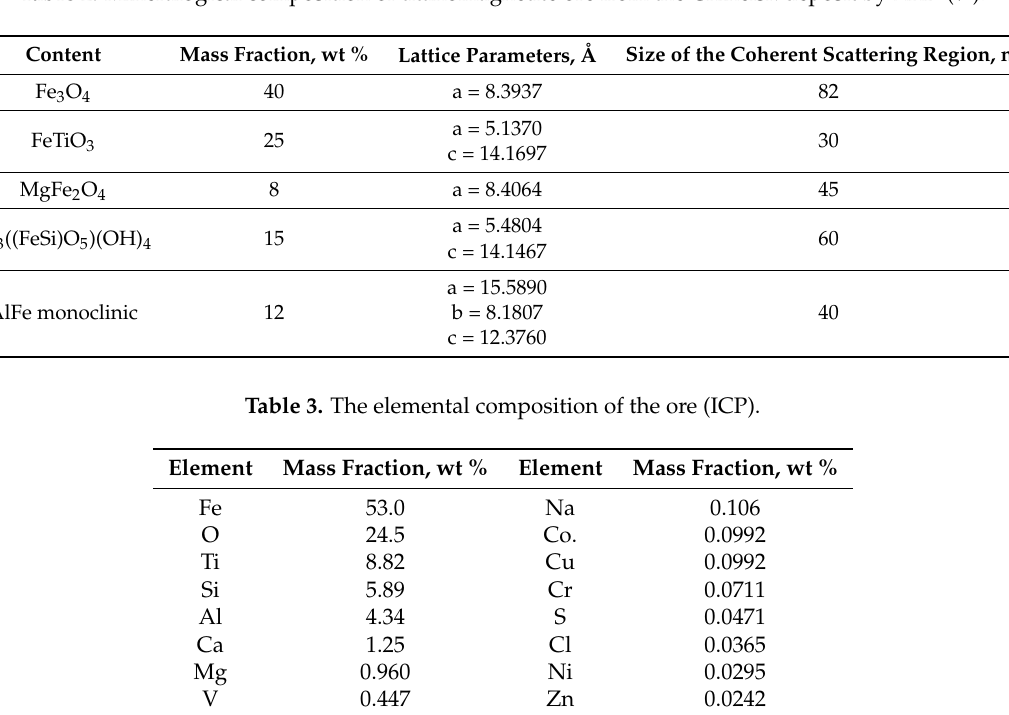
Table 3. The elemental composition of the ore (ICP).